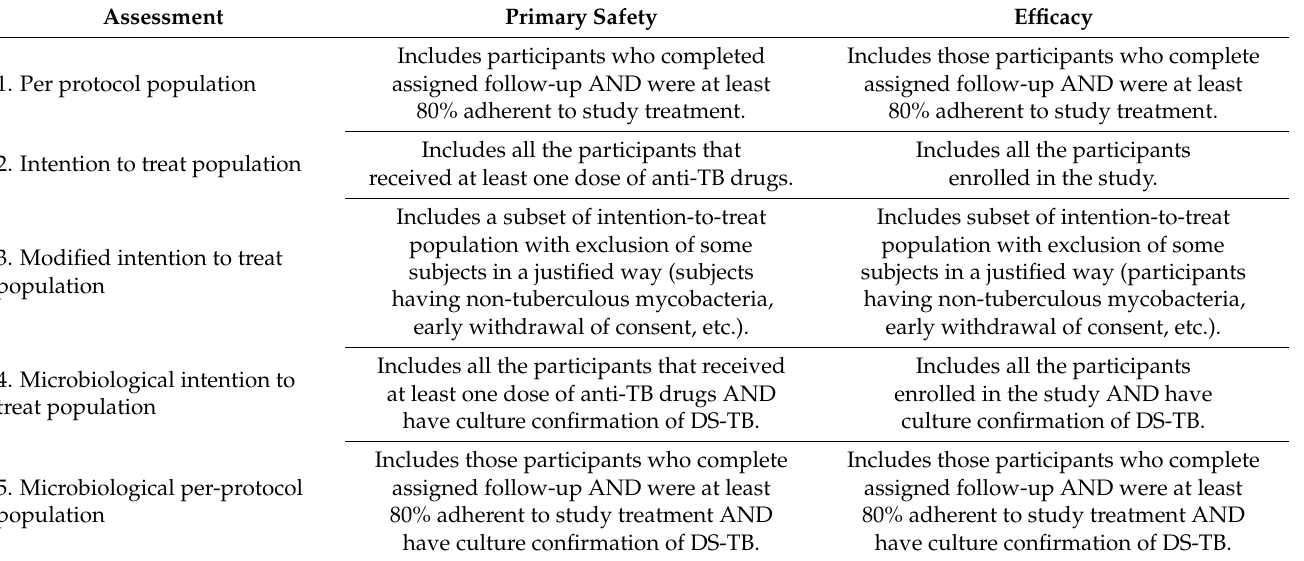
Table 2. Analysis populations and